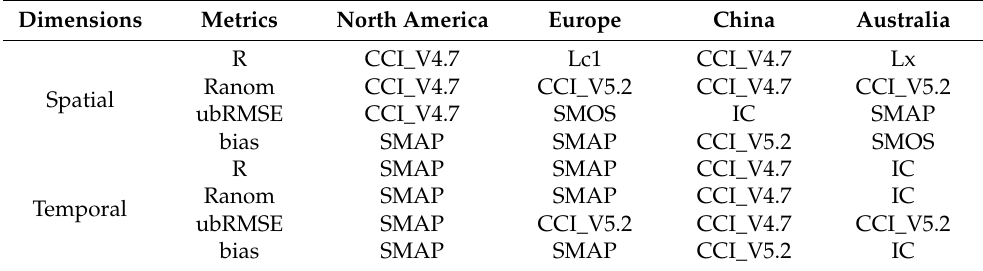
Table 1. The optimal product considering each spatial and temporal metric on each continent (the units of ubRMSE and bias are m 3 · m − 3